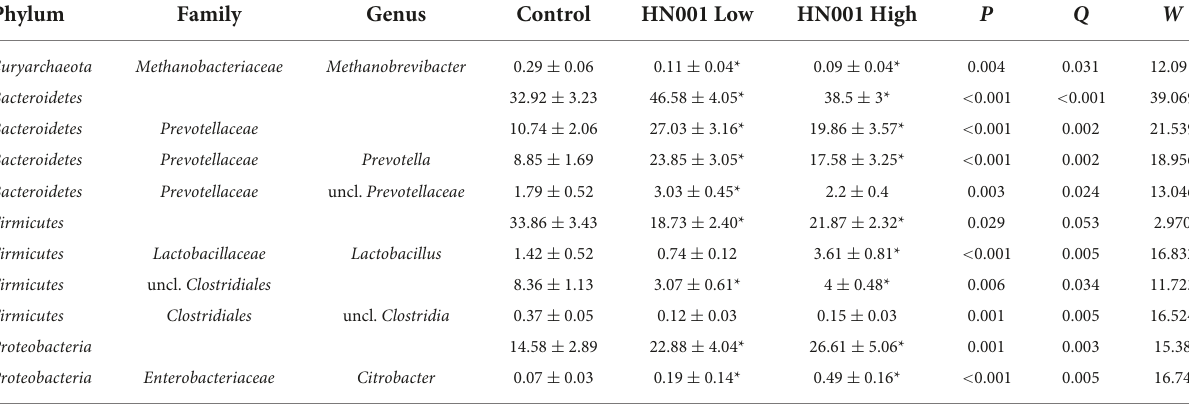
TABLE 1 Microbial taxa at the genus level and higher with > 0.1% mean relative abundances in the cecum with significant differences (global ANCOM-BC Q < 0.05) between piglets fed infant formula supplemented with L. rhamnosus HN001 and control formula.